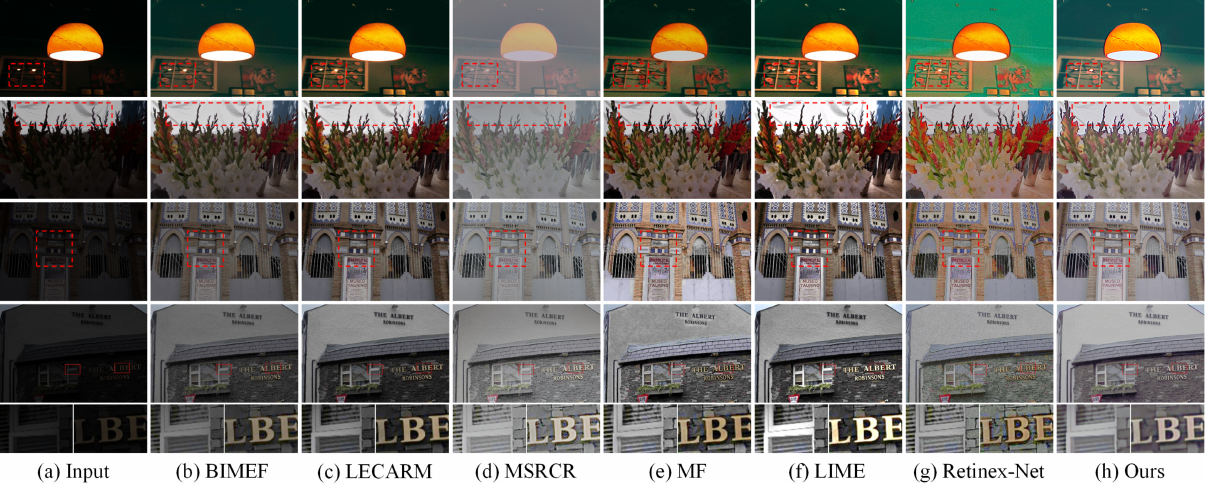
Figure 7. Visual comparison of the proposed method and the state-of-the-art methods on images from LIME [19,39] and SICE [38].